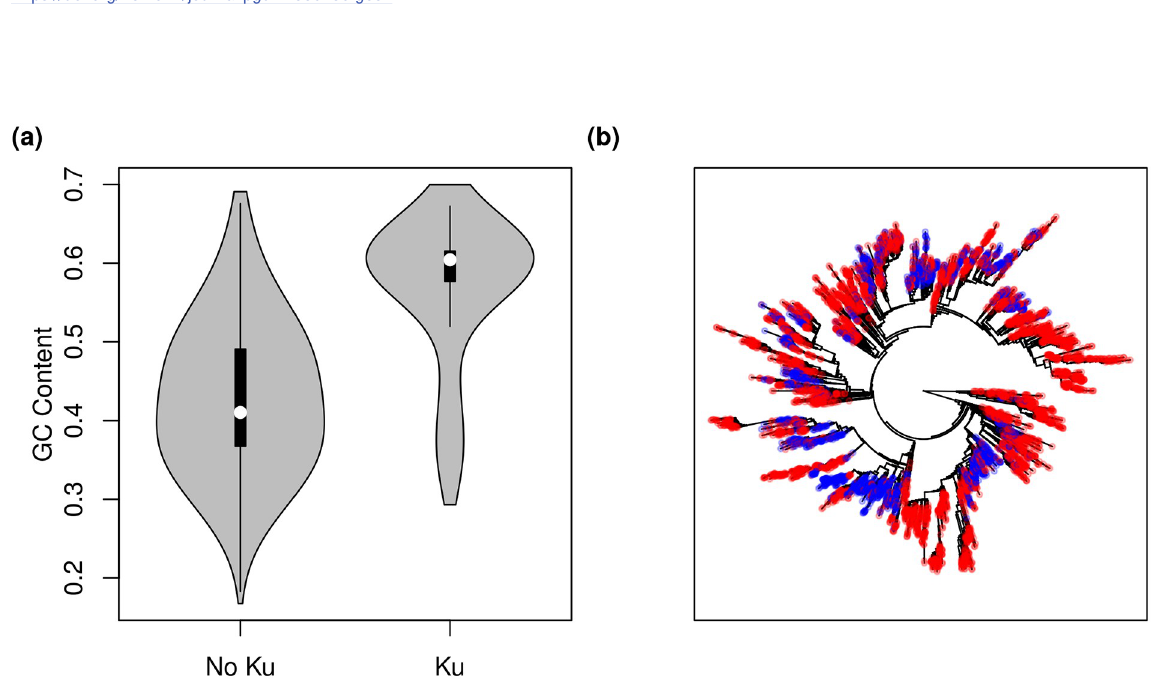
Fig 2. The relationship between genomic GC content and the NHEJ pathway in prokaryotes. (a) Microbes that code for the Ku protein tend to have much higher genomic GC content than those that do not (all RefSeq assemblies shown, 21389 out of 104297 genomes encode Ku). (b) Ku incidence mapped onto the SILVA Living Tree [64]. While Ku incidence is not randomly distributed across the prokaryotic tree, neither is it isolated to a particular clade. Organisms coding for Ku shown in blue, those not coding for Ku shown in red.